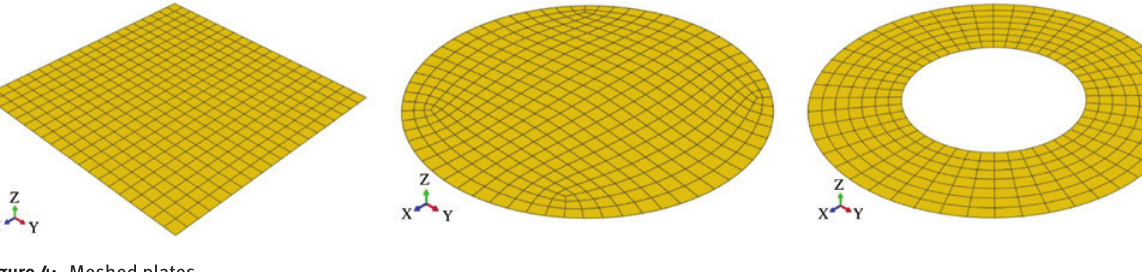
Figure 4: Meshed plates.